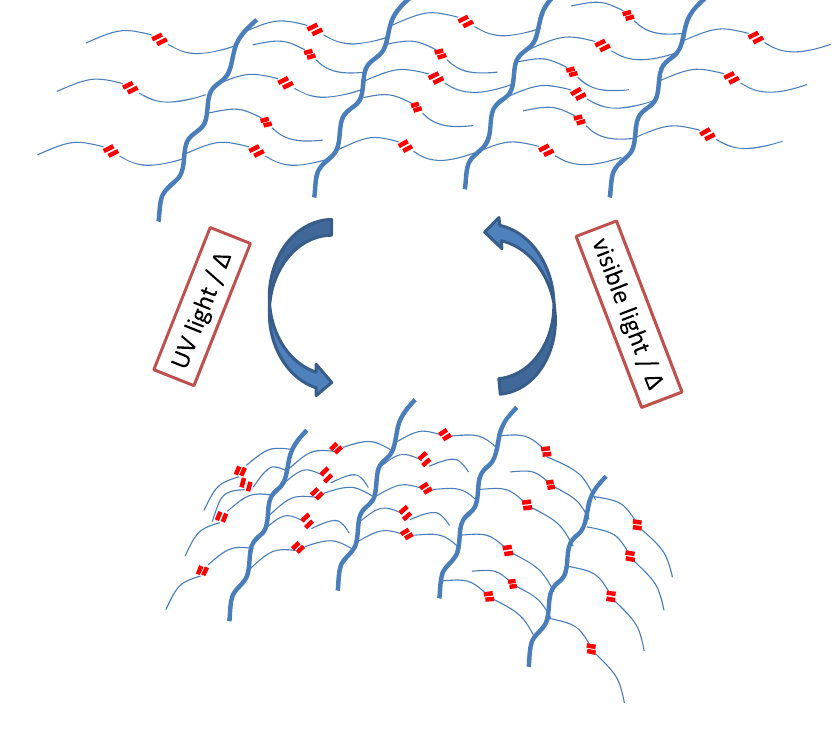
Figure 2. Schematic representation of photo-responsive SCP process. Polymer chains functionalized with photo-active molecules subject to shape change on exposing it to suitable wavelength of light. The original shape is recovered as soon as the stimulus is turned